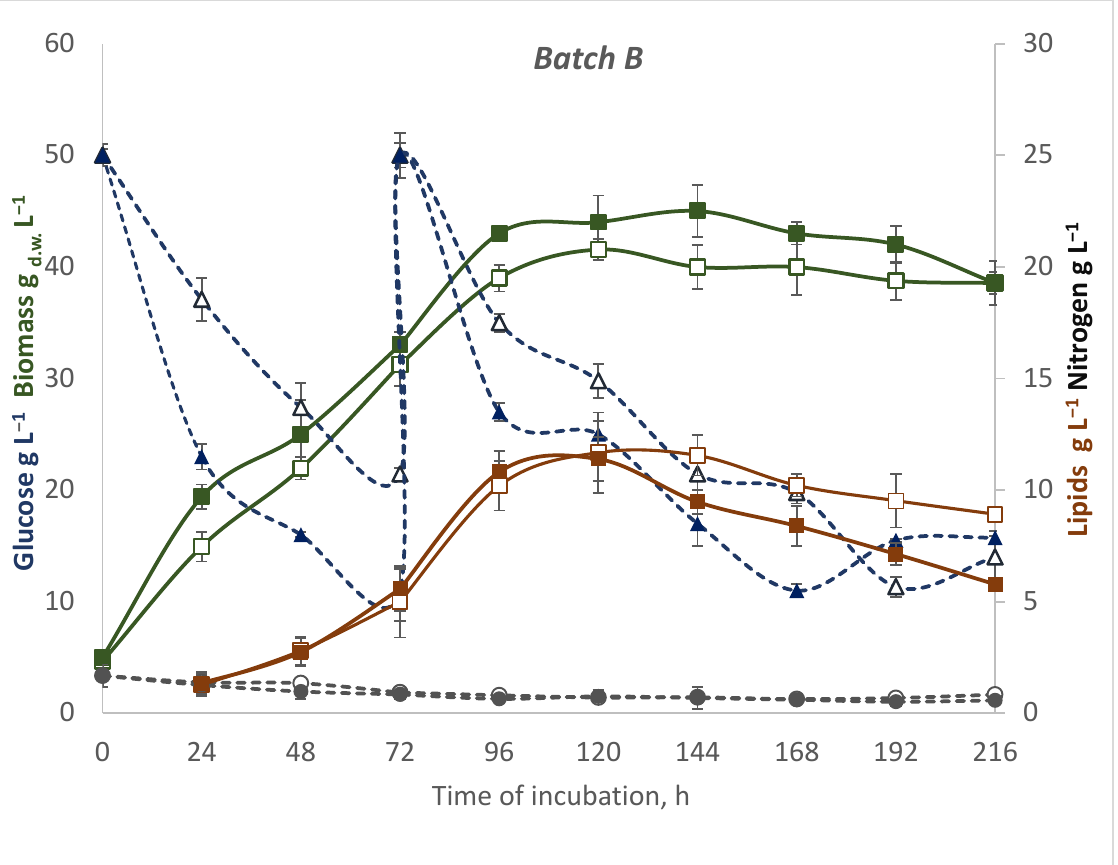
Figure 2. The timecourse of a fed-batch (B) culture of R. glutinis var . rubescens in DPW at two temperatures: 28 °C (filled tags) and 20 °C (empty tags). Kinetics of substrates: glucose — blue dotted line, nitrogen — grey dotted line, biomass (where d.w. — dry weight) — green line, lipids — brown line. Values represent the average of duplicate experiments.